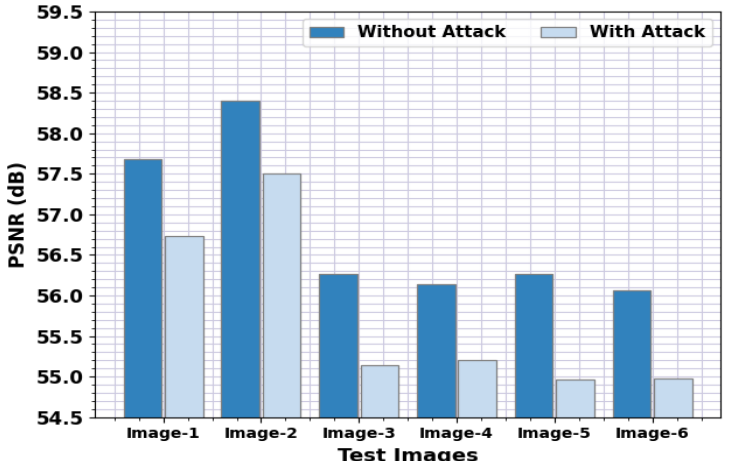
Figure 5. PSNR analysis of the PPIE-ODLASC system under with and without attacks. Table 4. PSNR analysis of the PPIE-ODLASC system with other approaches under different images.